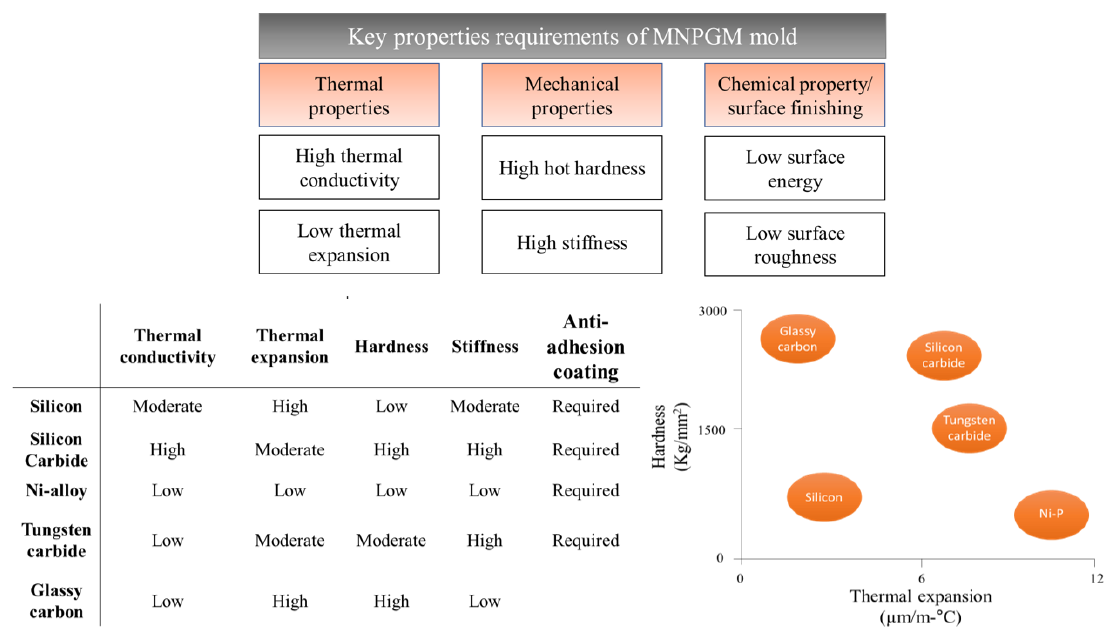
Figure 2. Important properties required of MNPGM molds and a comparison of their material properties.